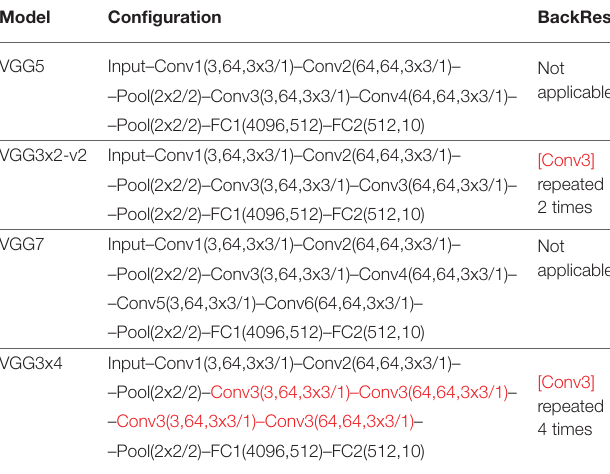
TABLE 9 | CIFAR10 network topologies for AGD training